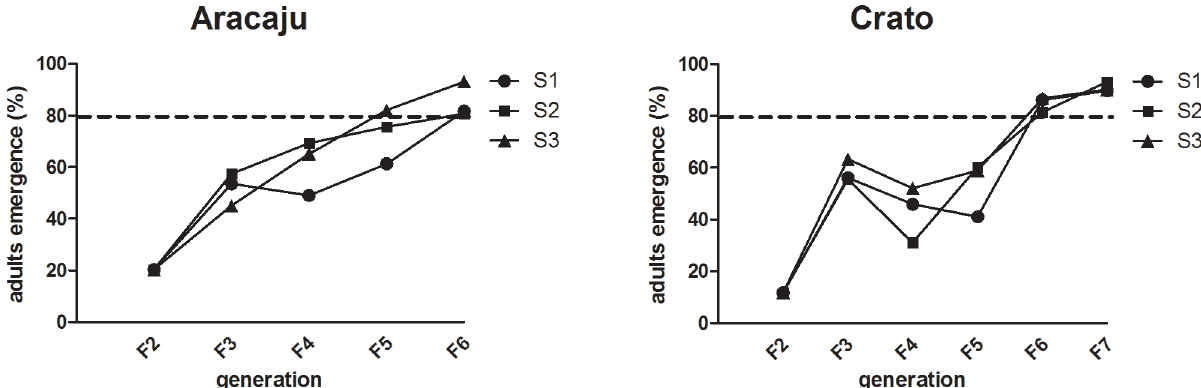
Fig 1. Survival rate of two Aedes aegypti populations subjected to selection with a fixed dose of malathion. Exposure to the insecticide was continuous, between L3 and pupal phases. The x-axis indicates the generations of laboratory rearing.